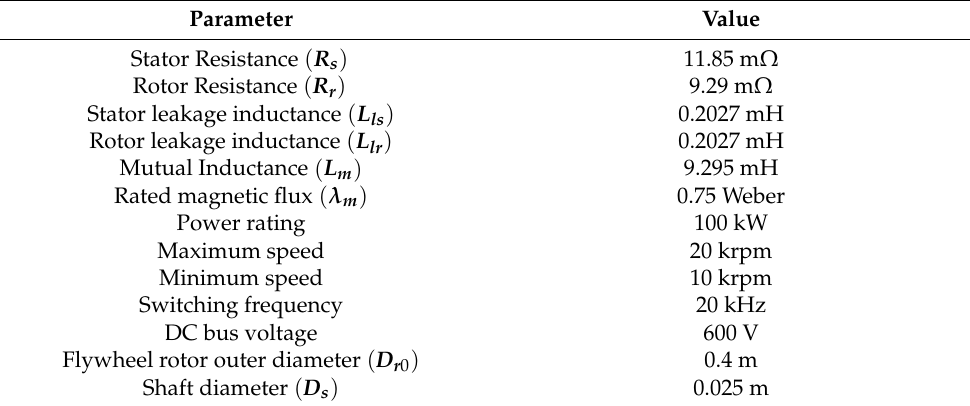
Table 1. Parameters of proposed